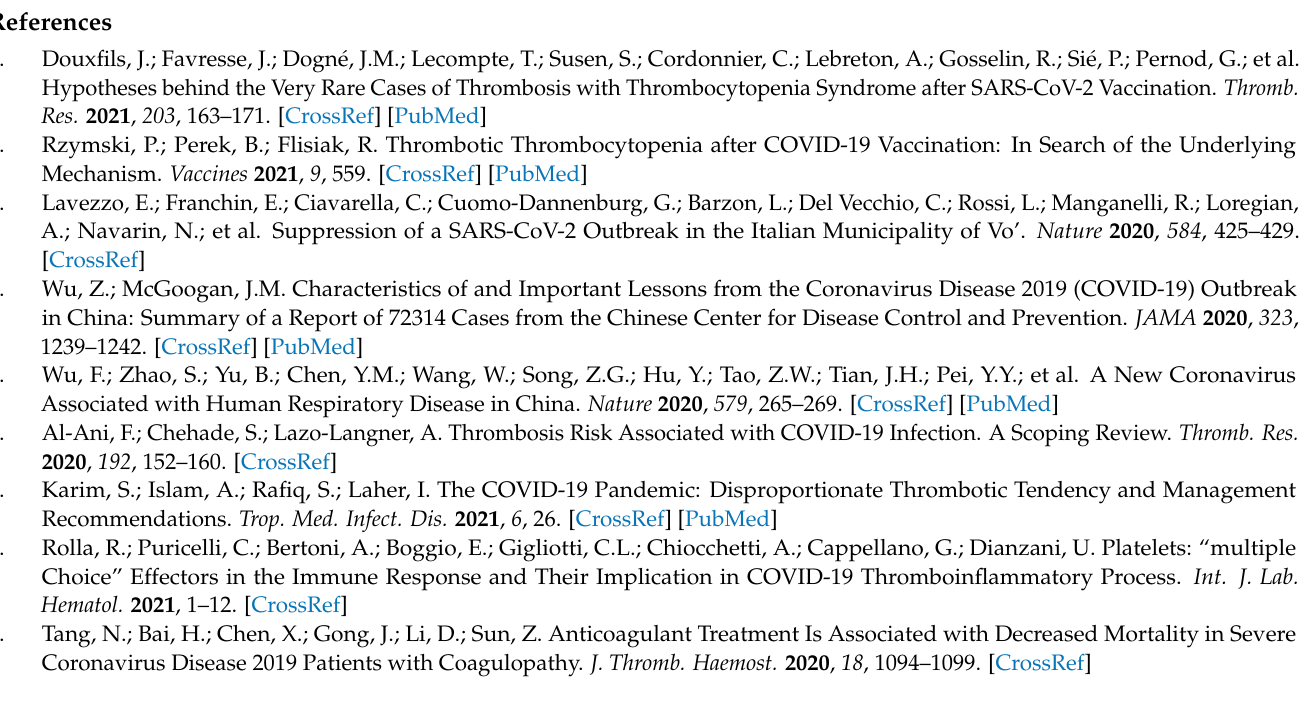
Figure 1 original crafted by K.J. All authors have read and agreed to the published version of the